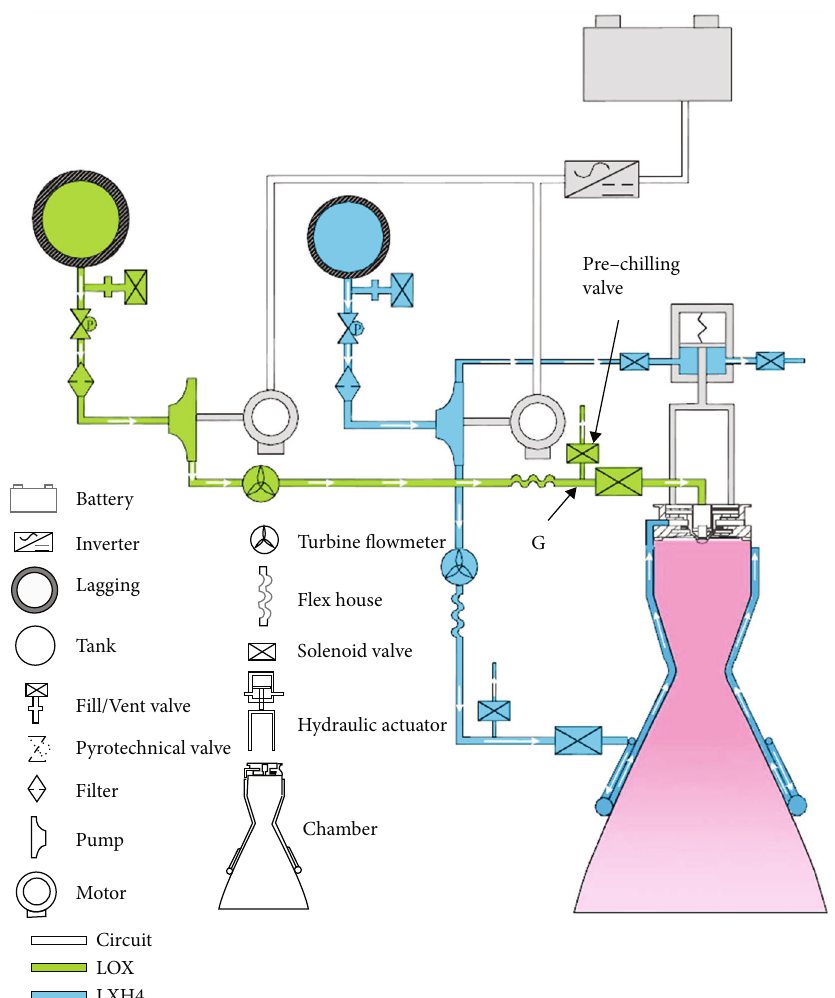
Figure 2: Sketch of a typical low-pressure cryogenic engine [25].